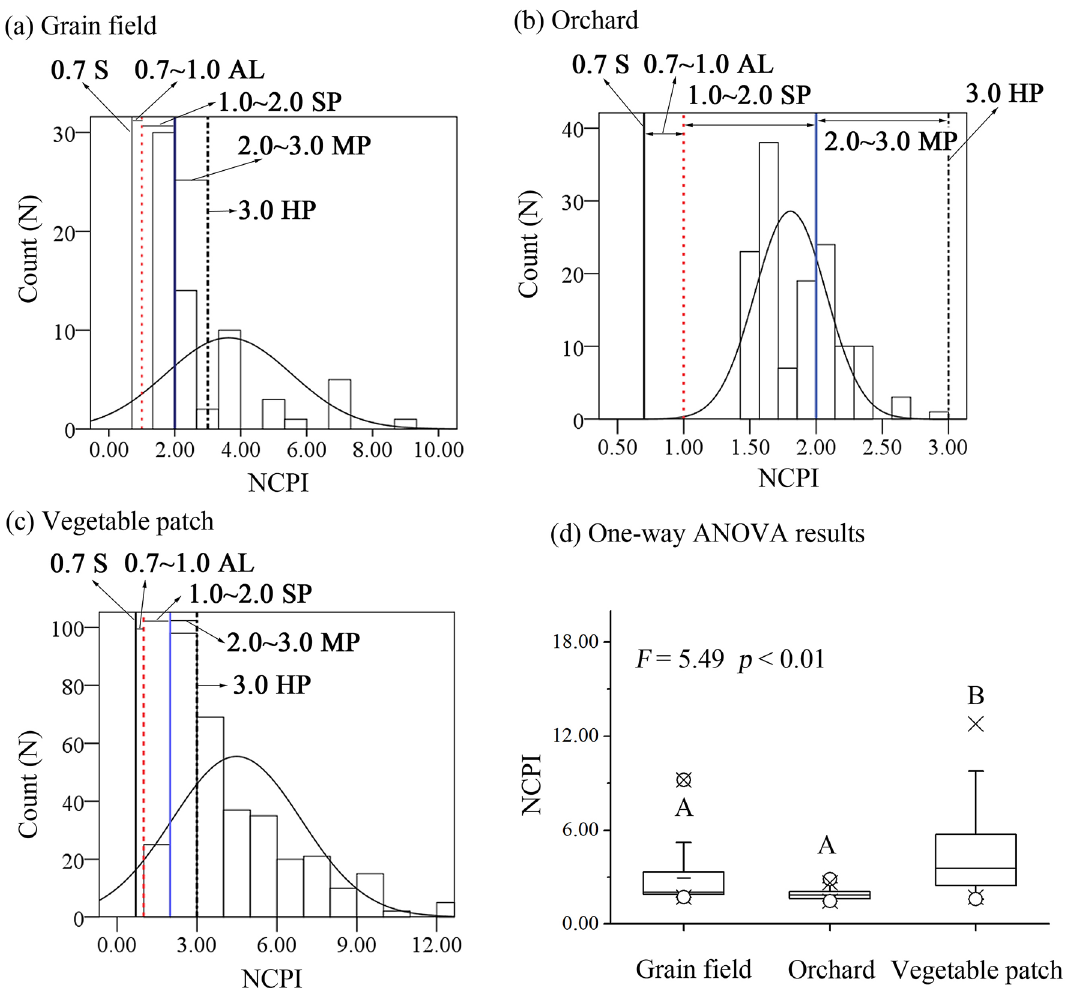
Figure 1. Count distribution and the difference of soil NCPI among three farmland soils. S, AL, SP, MP and HP indicate security, alert level, slight pollution, moderate pollution and heavy pollution,